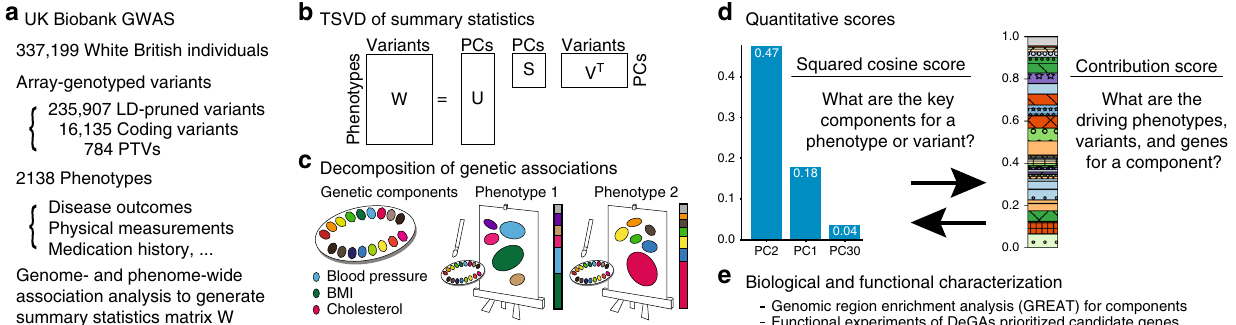
Fig. 1 Illustrative study overview. a Summary of the UK Biobank genotype and phenotype data used in the study. We included White British individuals and analyzed LD-pruned and quality-controlled variants in relation to 2,138 phenotypes with a minimum of 100 individuals as cases (binary phenotypes) or non-missing values (quantitative phenotypes) (Supplementary Table 1, Supplementary Data 1). b Truncated singular value decomposition (TSVD)